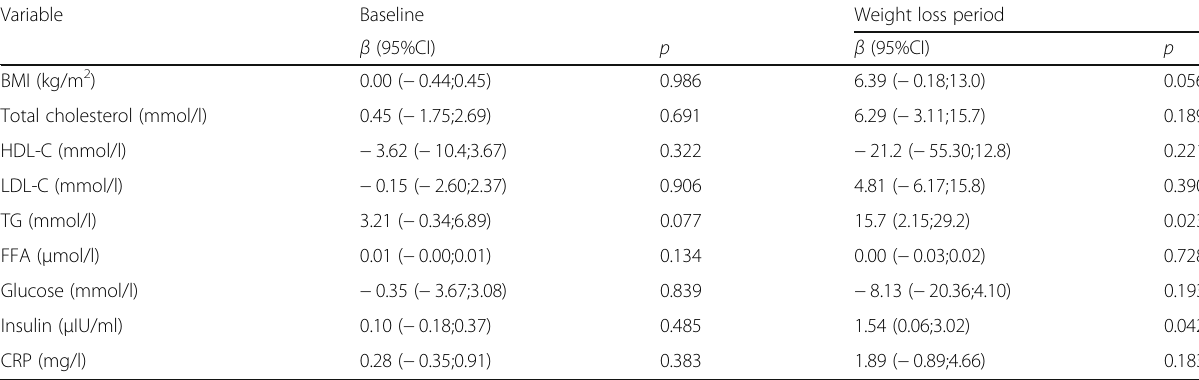
Table 2 Plasma ANGPTL3 and association with BMI and lipid profile